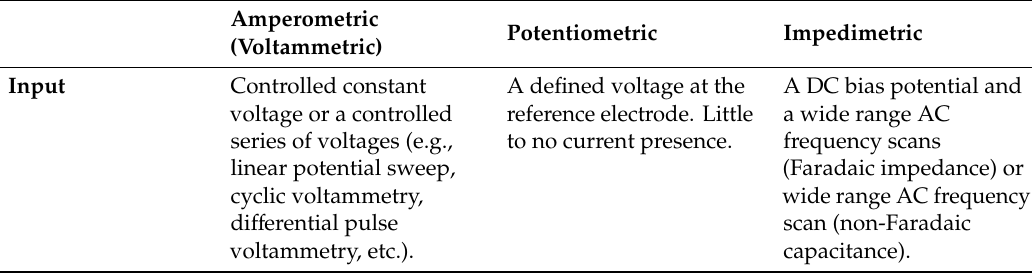
Table 1. Electrochemical biosensor classifications and their advantages and disadvantages in environmental water monitoring.